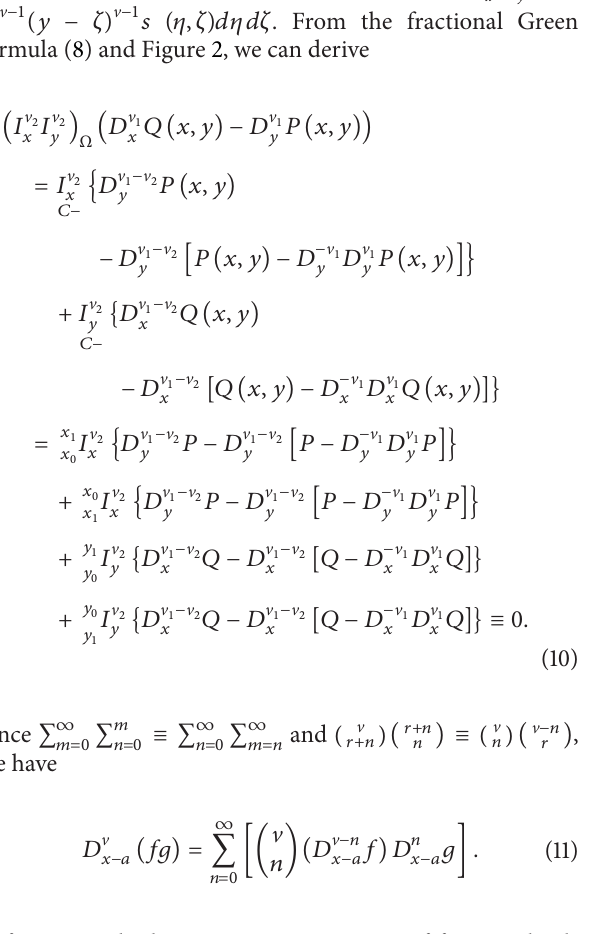
smooth boundary 𝐶 is also a rectangular closed curve, as shown in Figure